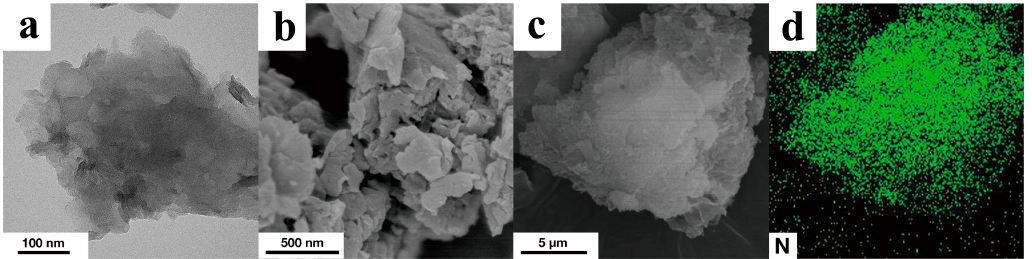
Figure 3. ( a ) TEM image, ( b , c ) SEM images, and ( d ) N elemental distribution in the same region of a g − C 3 N 4 sample.